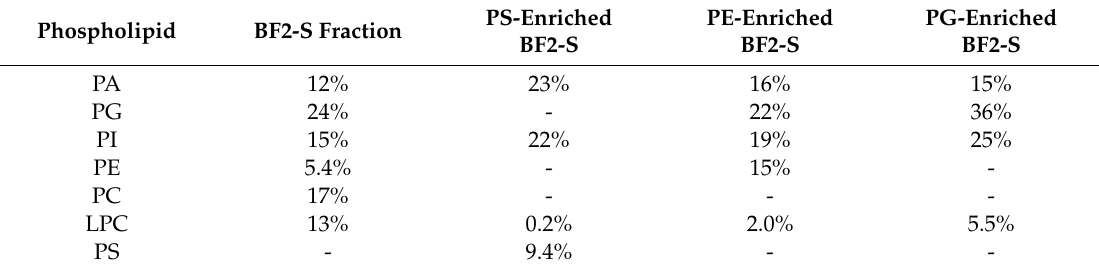
Table 4. Composition of PX-enriched BF2-S compared to starting BF2-S fraction (results obtained by HPLC